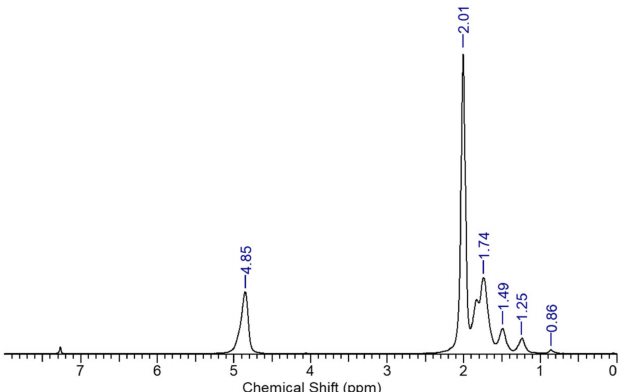
Figure 4. 400 MHz 1 H NMR spectrum of the poly(ethylene- co -vinyl acetate), produced via CD-assisted aqueous free radical polymerization, in CDCl 3